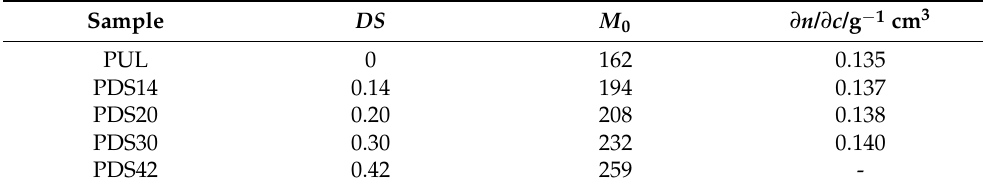
Table 1. Degrees of substitution ( DS ), the average molar masses per unit glucose residue ( M 0 ), and the refractive index increments ( ∂ n/ ∂ c ) of polydisperse pullulan (PUL) and octenyl succinic anhydride-modified pullulan (PUL-OSA) samples used in this